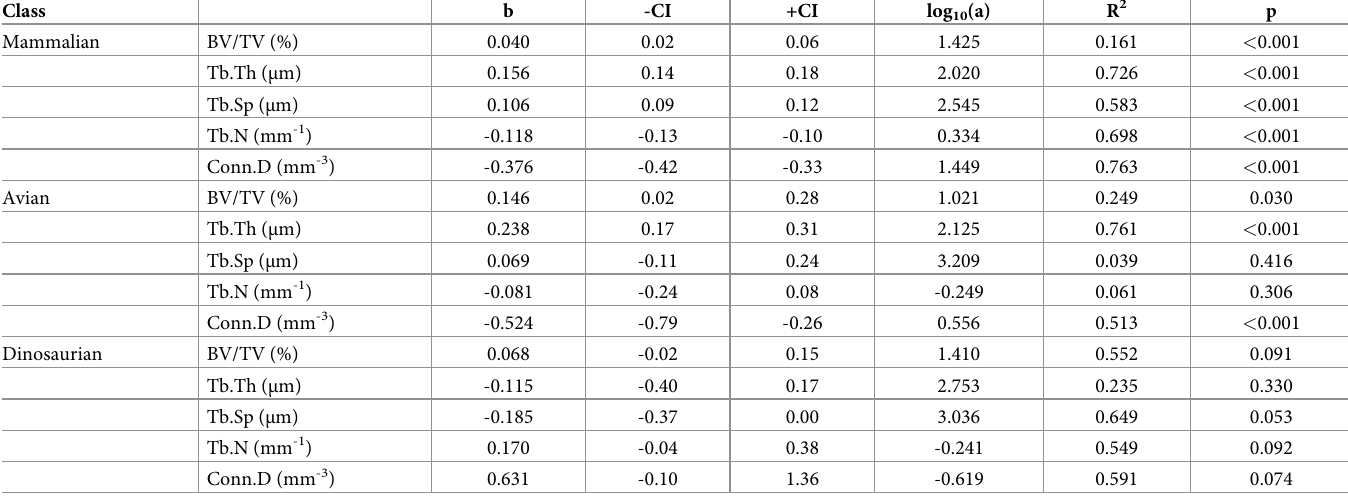
Table 2. Allometry linear regression results: Slope (b), with 95% confidence intervals (CI), intercept ( log 10 ( a )), coefficient of determination (R 2 ), and p-values for the regression slopes. Class